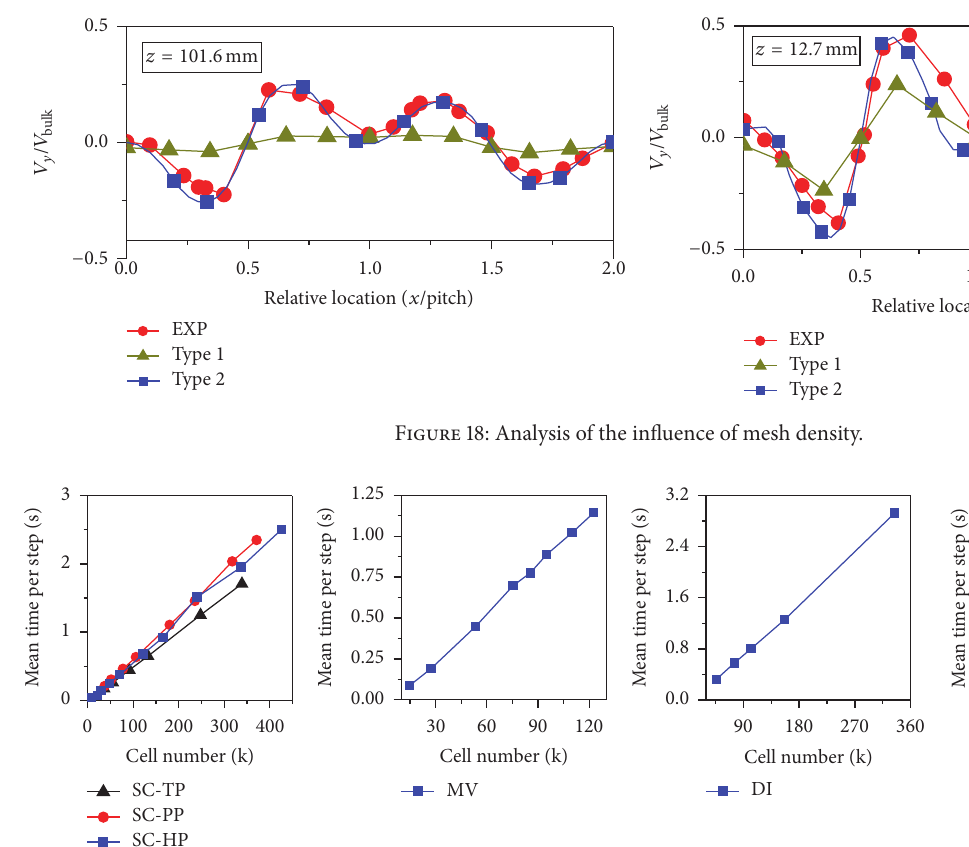
Figure 17: Mesh types for comparison.